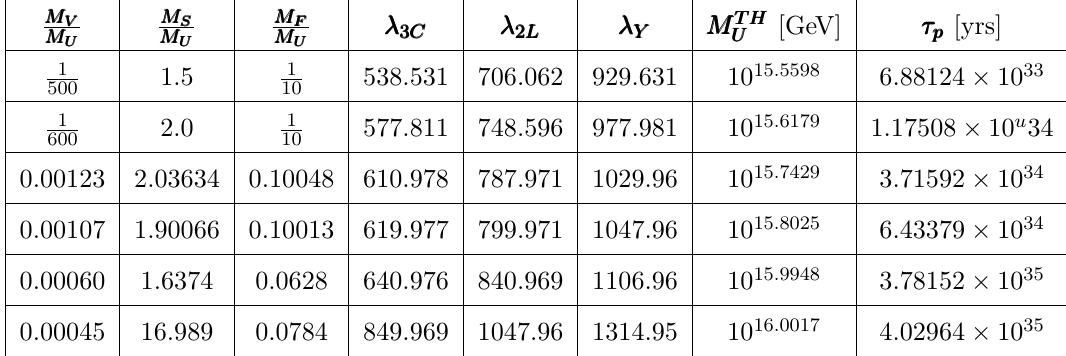
Table 4 . Numerically estimated values for M U and τ p by considering one-loop threshold